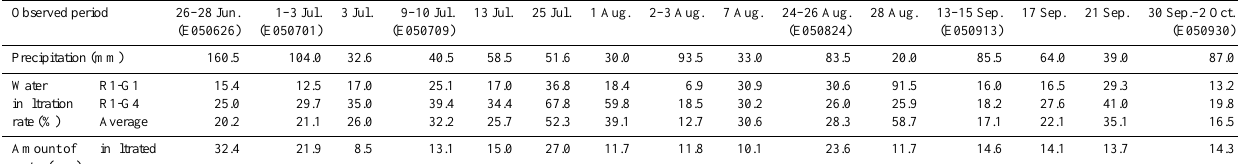
Table 6. The precipitation, water infiltration rate, and amount of infiltrated water at R1. Observedperiod 26–28Jun.